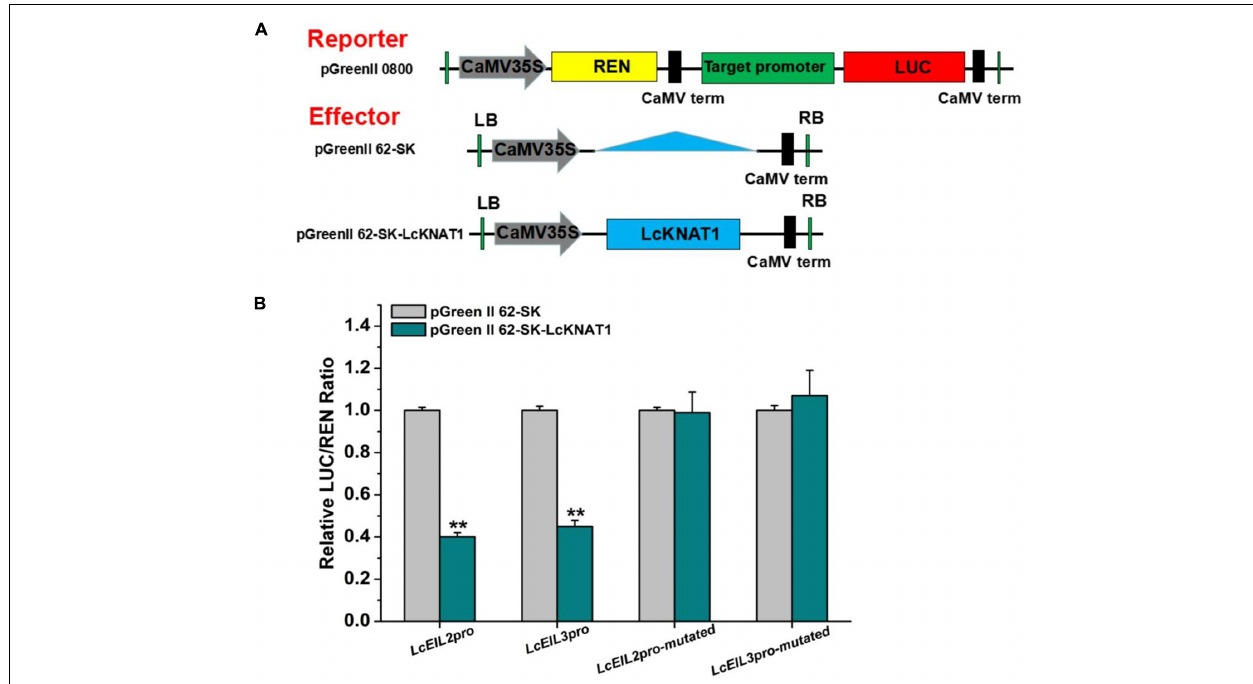
FIGURE 4 | LcKNAT1 represses the transcriptional activity of LcEIL2 and LcEIL3 . (A) Schematic representation of the double reporter and effector plasmids used for LcKNAT1 transcriptional activity assay on target gene promoters. (B) Transient expression assays on LcKNAT1 transcriptional repression of LcEIL2 and LcEIL3 . The reporter and effector vectors were co-introduced into tobacco leaves. After 48-h incubation, the suppression of LcEIL2/3 and mutated LcEIL2/3 promoters by LcKNAT1 was shown by the ratio of LUC/REN. Mutated LcEIL2/3 promoters were as shown in Figure 3 . Each value represents the means of six biological replicates, and vertical bars represent ± SD. Asterisks indicate a significant difference (Student’s t -test: ** P < 0.01).